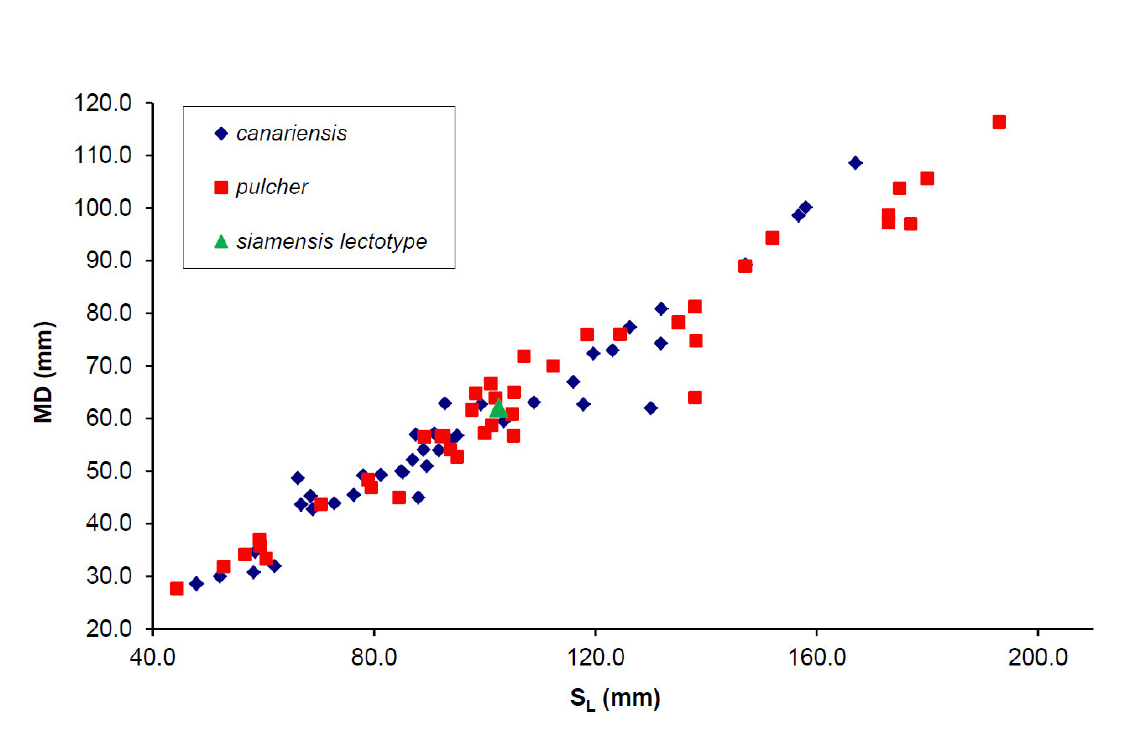
, mm) for K. canariensis sp. nov. L